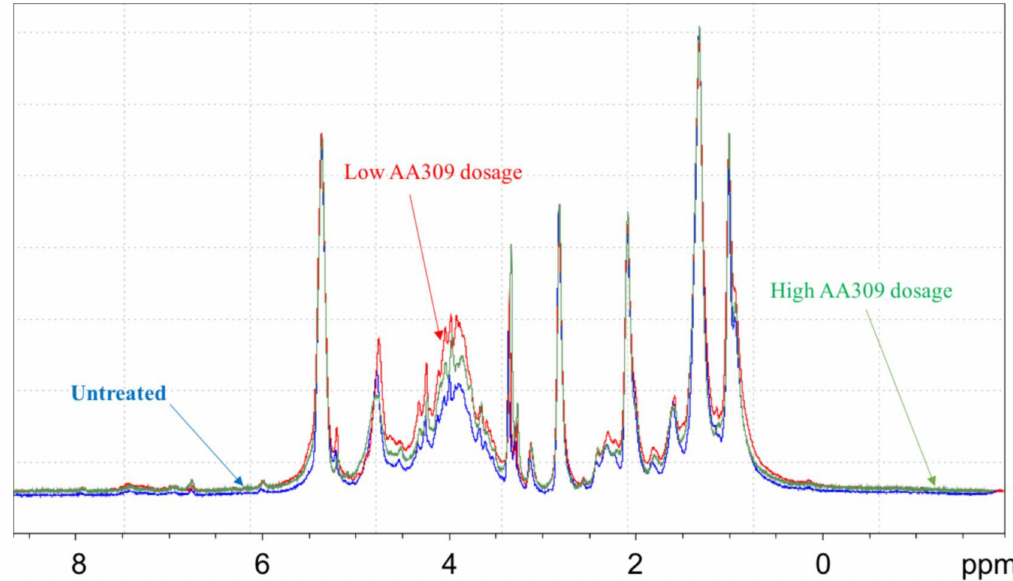
Figure 8. 1 H HRMAS NMR spectra of leaves in D 2 O (MASr 12 kHz, 298 K) acquired with the Bruker sequence ledbpgp2s1d. Different colours are referred to different treatments to which plants were subjected: AA309 untreated (control, blue), low AA309 dosage (=2.1 mg/kg N) (red), high AA309 dosage (=4.2 mg/kg N)